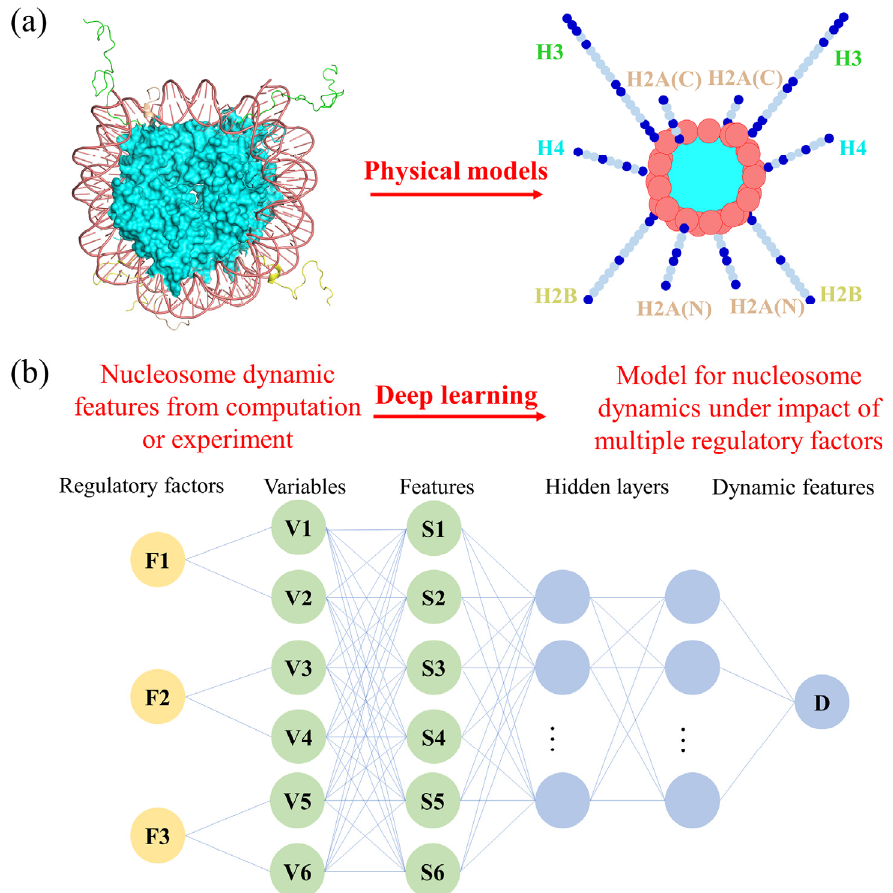
Figure 3. Promising approaches for the study of the mechanism of nucleosome dynamics by multiple regulatory factors. ( a ) The specific physical models of nucleosomes are depicted by the three-site-per-nucleotide and the atomic-interaction-based coarse-grained (3SPN-AICG) model. The features of nucleosome dynamics can be depicted by the physical model combined with the model force field and the equations of motion. ( b ) The deep learning method to learn the model for nucleosome dynamics under the impact of multiple regulatory factors. The multiple regulatory factors can be taken as the input features and the nucleosome dynamic features as the labeled data, and the potential relationship or comprehensive effect of different regulatory factors can be learned and applied for the prediction of a new impact.